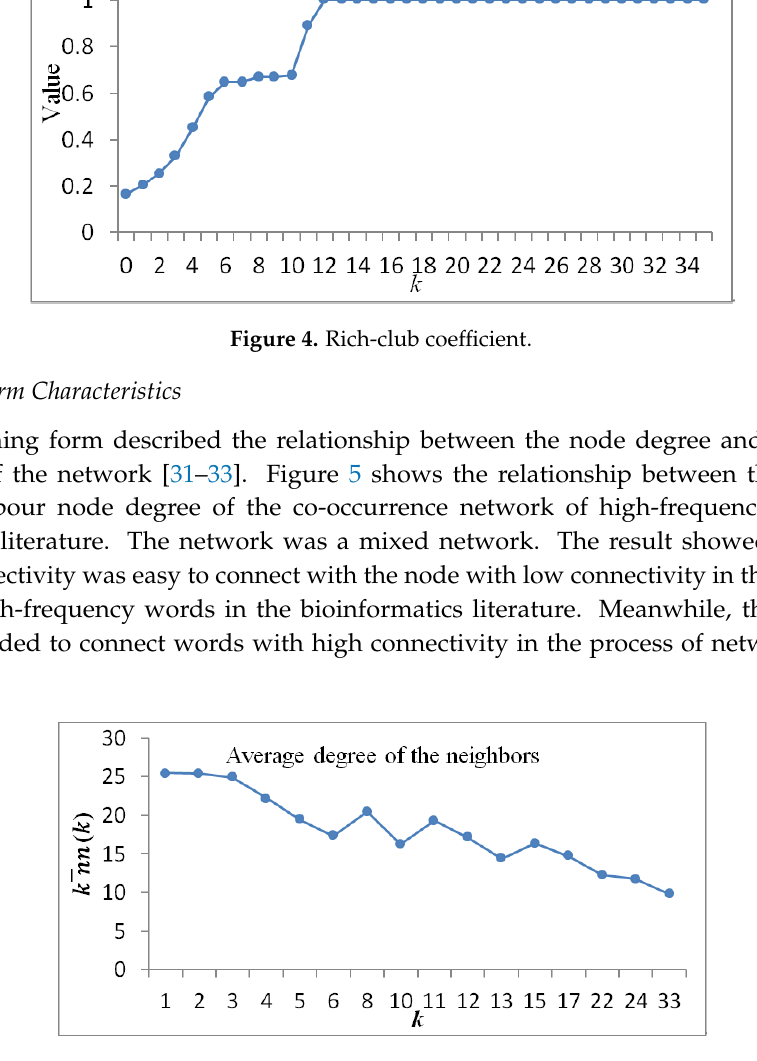
Figure 5. Average degree of the neighbours.